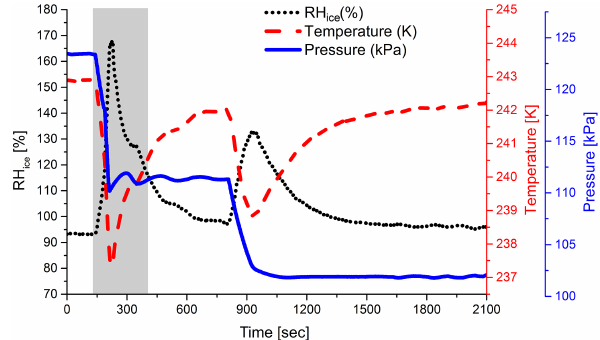
Figure 1. Example of programmable multistep expansion to form a mixed-phase cloud (Run no. 1291.16). Relative humid- ity with respect to ice (RH ice ) calculated from MBW instrument (MBW373LX) and thermocouples. Second step grows the present ice particles in the cloud period (25min). Shaded time period is analysed in Fig.